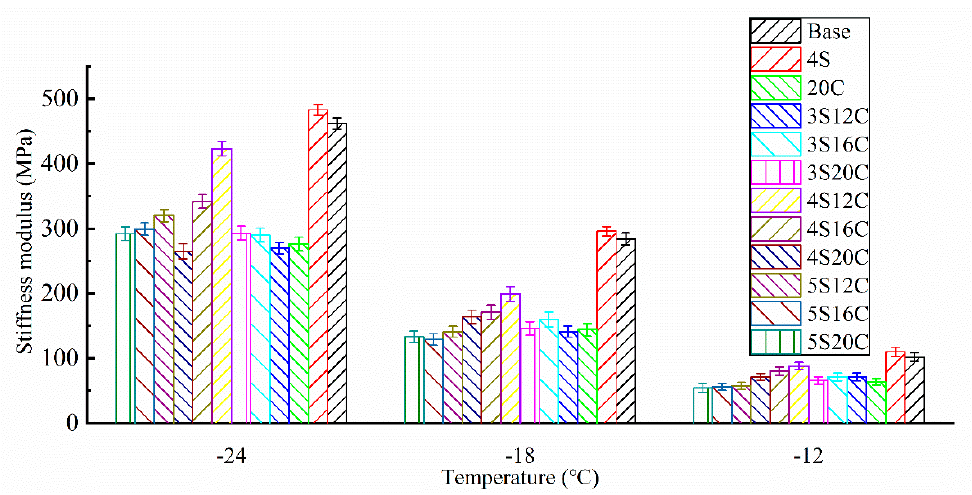
Figure 5. Stiffness modulus (S) of asphalt at different temperatures. Figure 5. Sti ff ness modulus (S) of asphalt at di ff erent